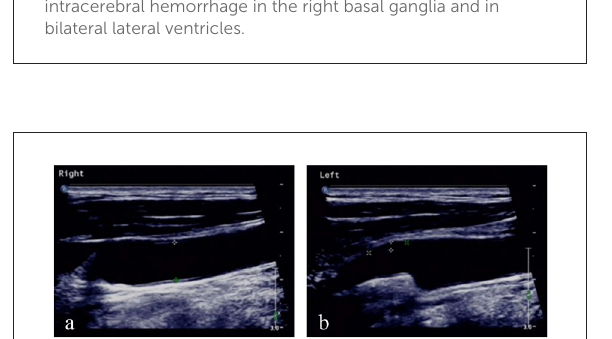
FIGURE2 Ultrasound of neck vessels. (a) Ultrasound of the right common carotid artery showed a diameter of 0.78cm and an intima-media thickness of 0.10cm. (b) Left common carotid artery ultrasound showed a diameter of 0.75cm, an intima-media thickness of 0.10cm, and a hypoechoic flat plaque (2.00 × 0.37cm) on the distal posterior